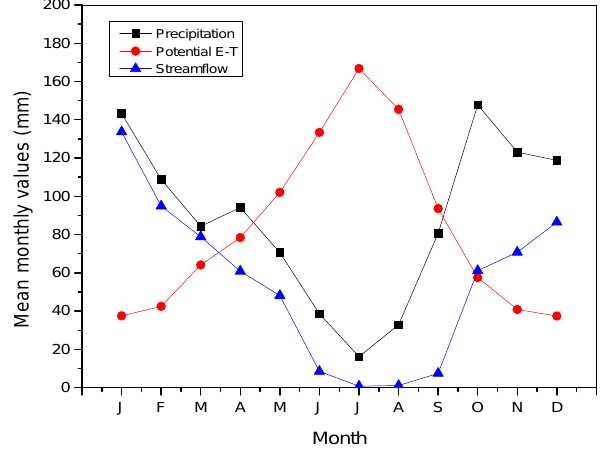
Figure 1. Mean monthly precipitation, potential evapotranspira- tion, and stream flow for the Rimbaud watershed in southern